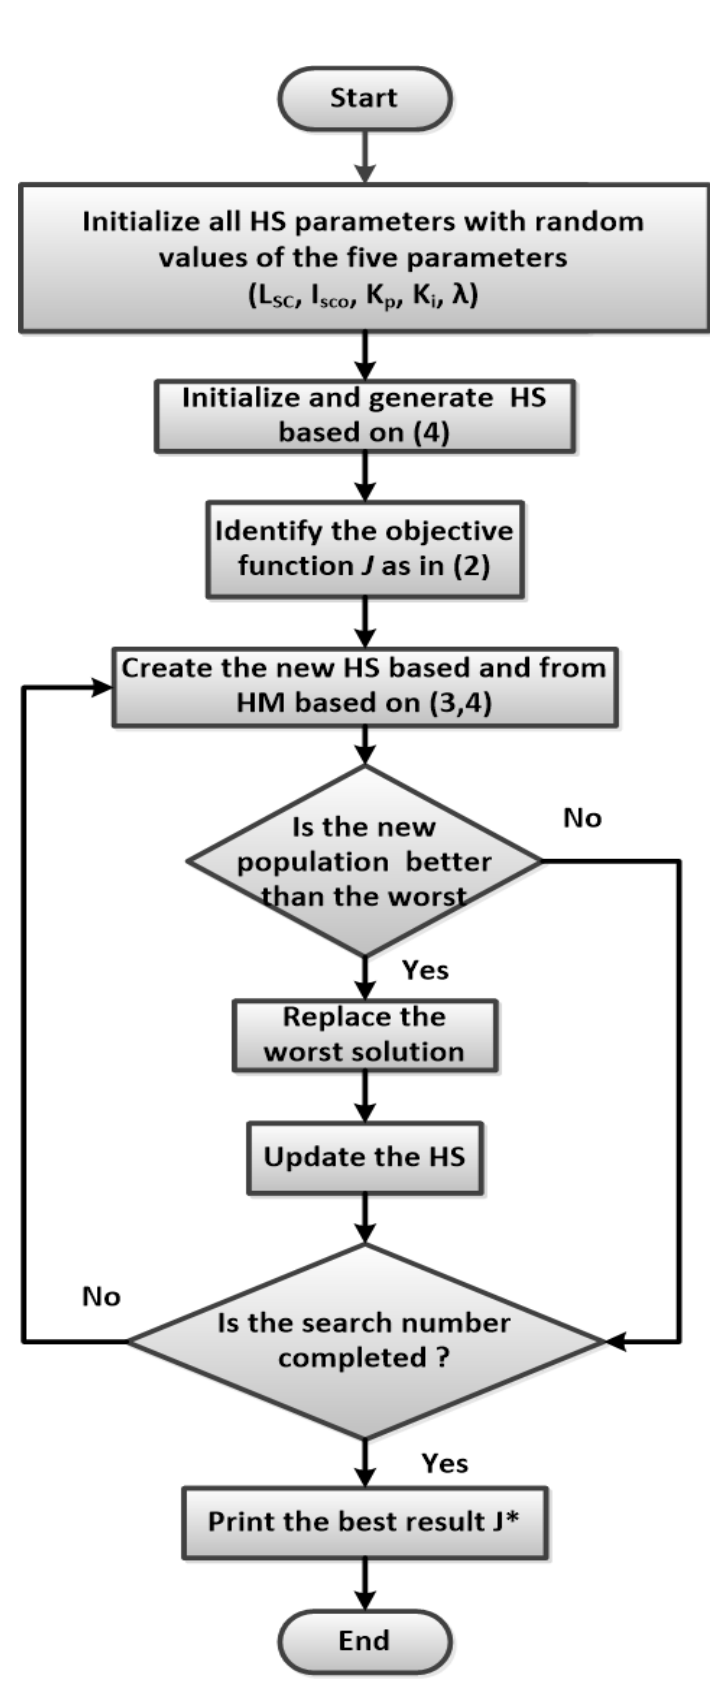
Figure 3. Flow chart of the HS optimization technique.